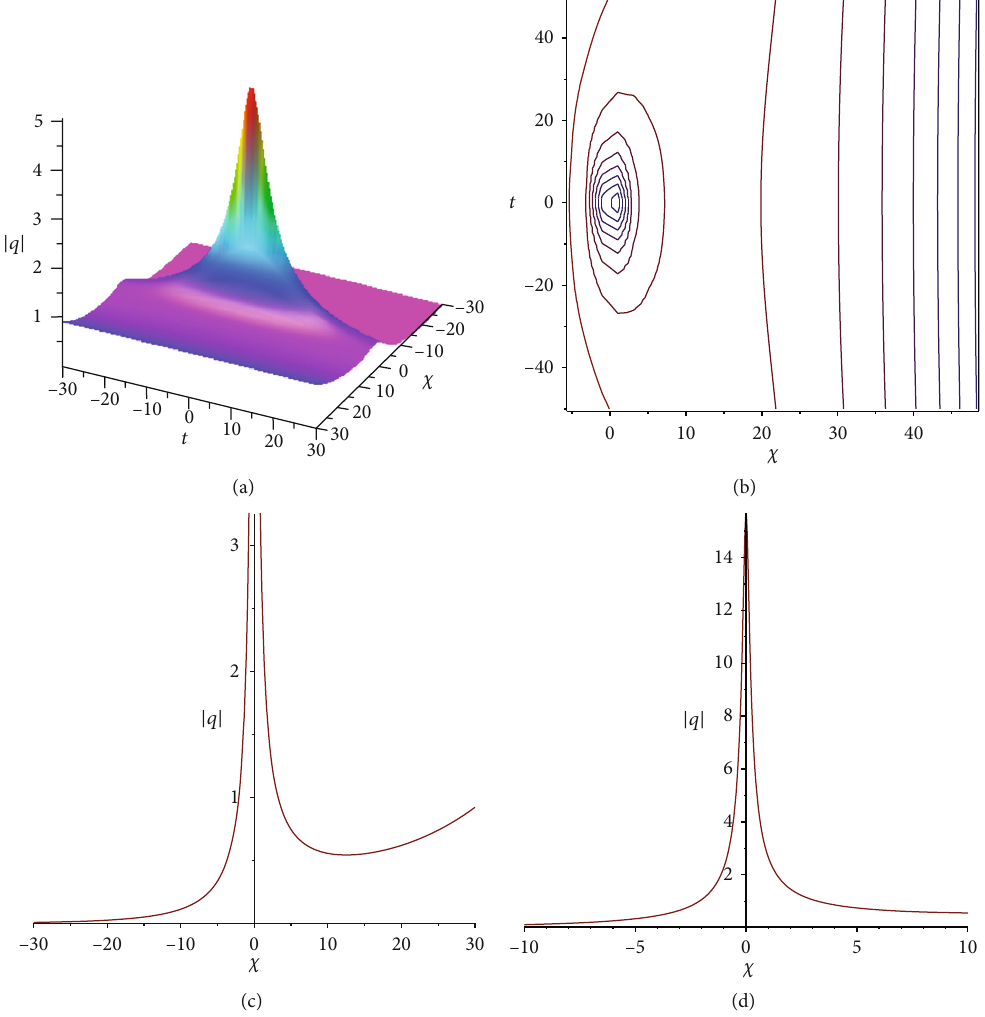
Figure 1: The one-fold particular solution evolution graph (a) and contour plot (b) for (20) with ε = 1, a = 0 : 2, b = 0 : 01 . (c) The waveform at t = 0 and (d) the waveform at t = 1